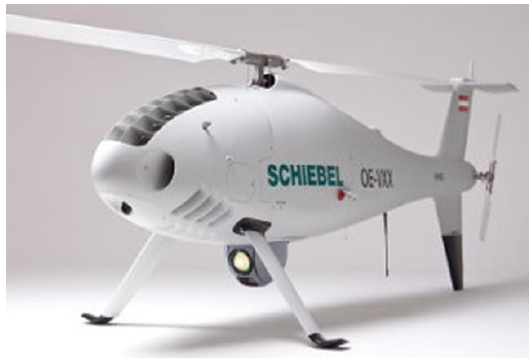
Figure 2. Schiebel’s Camcopter S-100